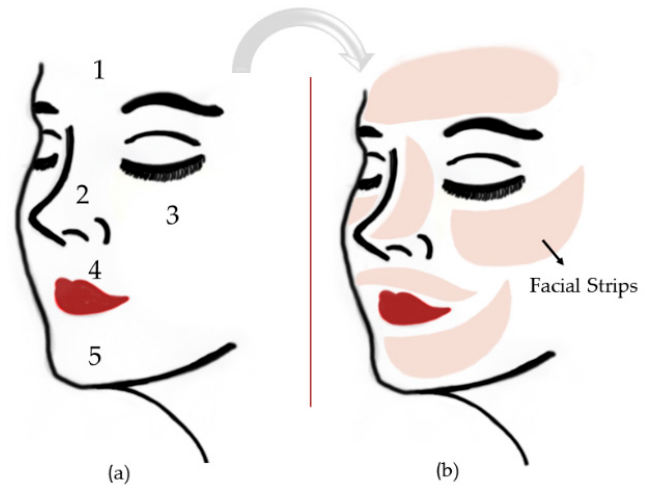
Figure 4. Main points to place facial strips being represented by numbers from 1–5 ( a ). Facial strips ( b ).